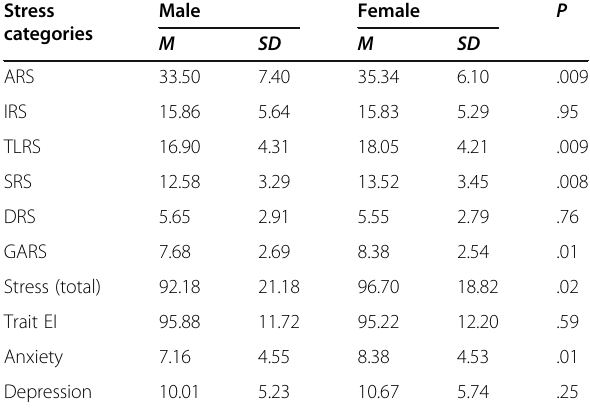
Table 3 Means and standards deviations according to